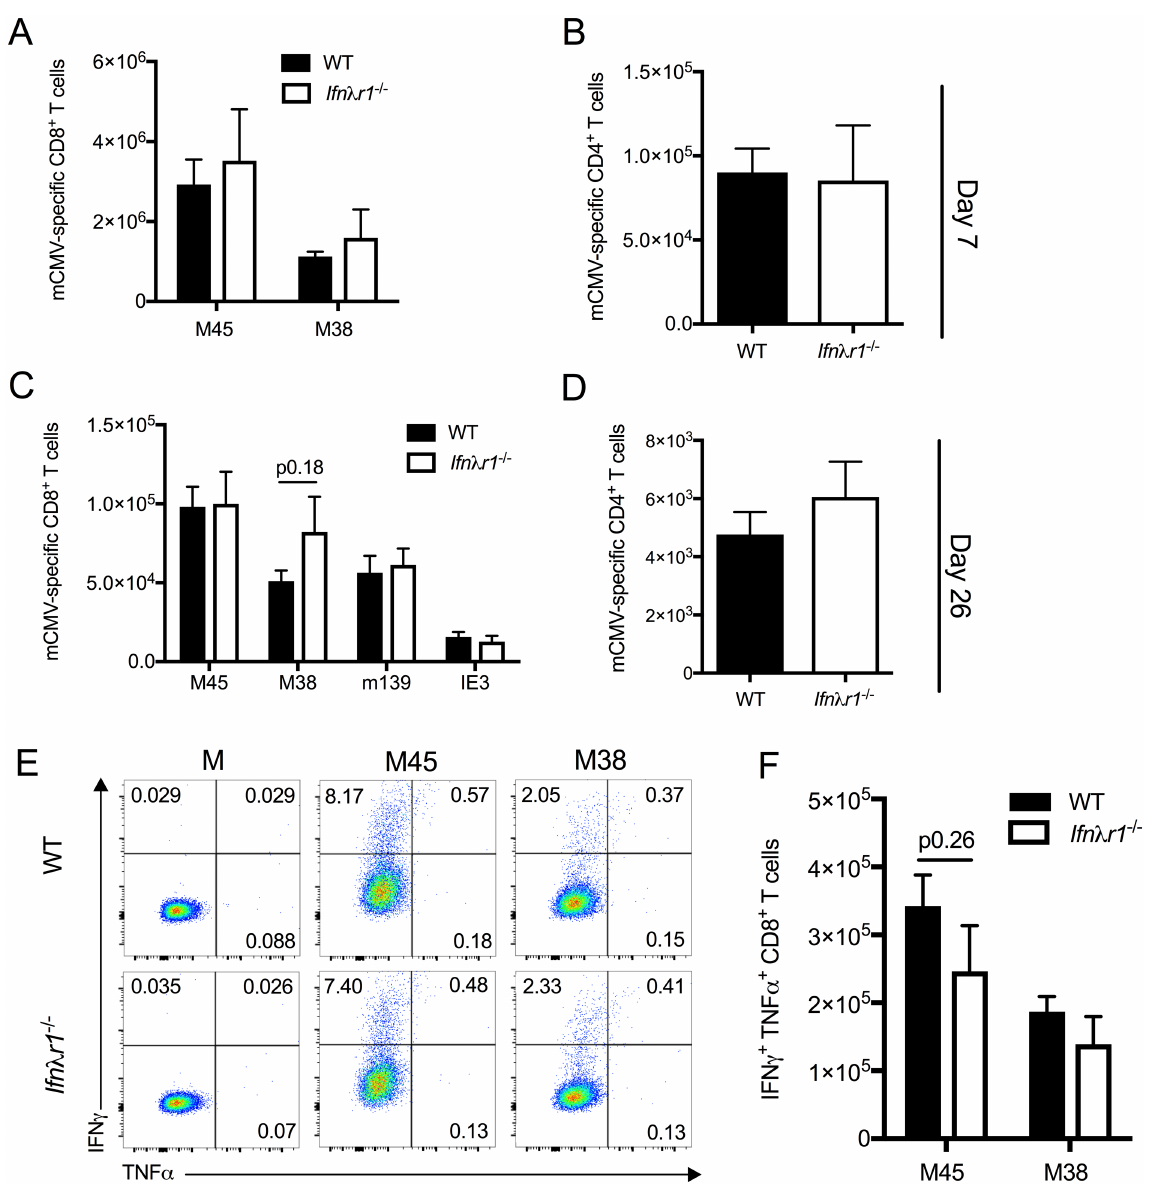
Fig 2. IFN λ R signaling does not influence mCMV-specific T cell responses in vivo . mCMV-derived peptide-specific CD8 + (A&C) and CD4 + (B&D) T cell responses in WT and Ifn λ r1 -/- mice infected for 7 (A&B) or 26 (C&D) days were quantified ex vivo following peptide re- stimulation. Mean + SEM of 6–7 mice/group is shown and represent 2–3 experiments. Statistical significance was tested using an unpaired student’s T-test. (E) Representative bivariate FACS plots of IFN γ and/or TNF α expression by CD8 + T cells stimulation with media alone (M) or 2μg/ml MHC class I restricted peptide derived from mCMV M45 (HGIRNASFI) or M38 (SSPPMFRVP) proteins. % positive cells are shown in the plots. Data are representative of 6 mice/group. (F) Mean + SEM from 6 mice/group is shown. Results represent 2 separate